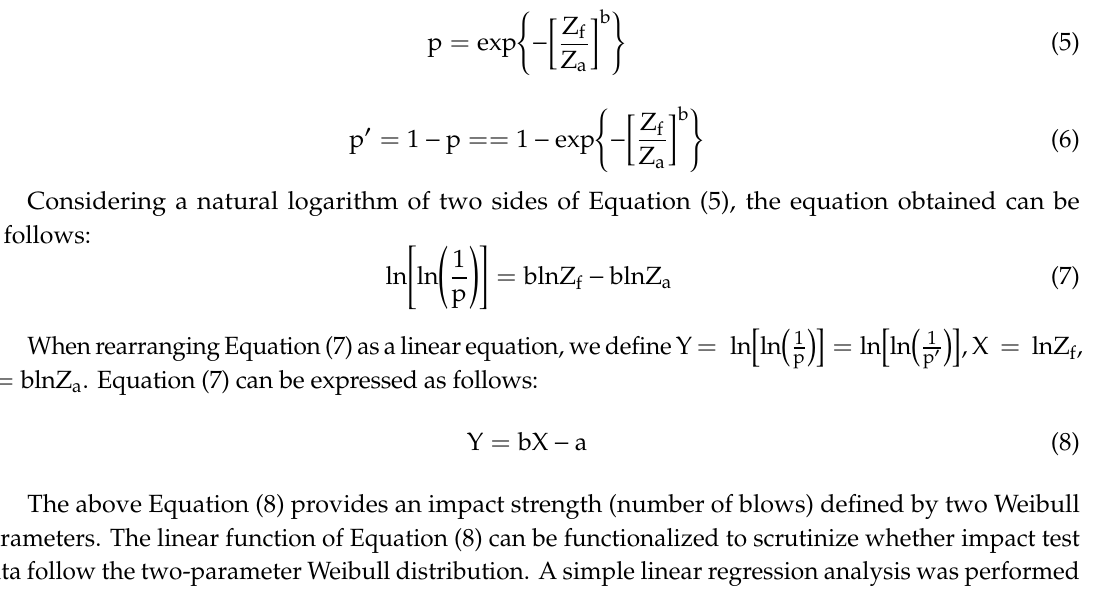
Figure 5. Weibull lines for mixes M4, M5, and M6. Table 4. Computed Weibull parameters. Mix Id